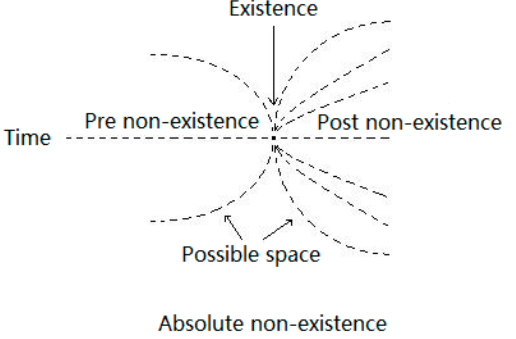
Figure 1. Relation between Existence and Nonexistence [11].